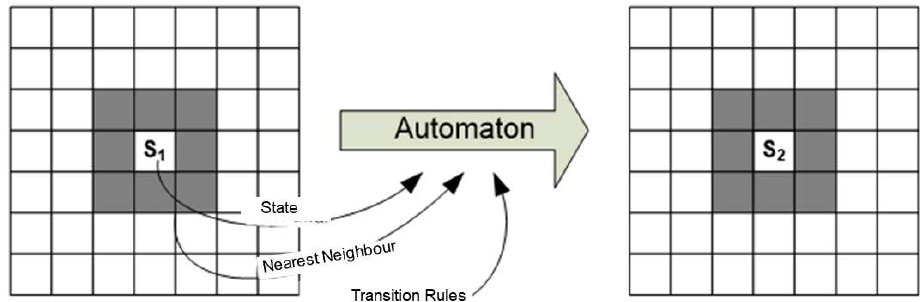
Figure 3. CA concept in determining the location of the automaton. An automaton is defined by the presence of the automaton state factor (class or value of the automaton) itself, the transition rule factor that will be imposed on the automaton, along with the neighboring factor of the automaton [35].